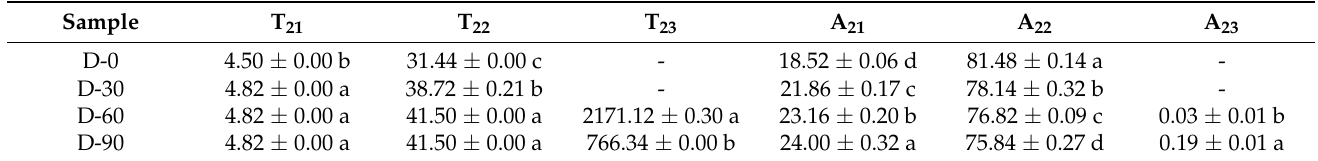
Table 2. Effect of proofing on the relaxation times, T 2 , and populations of CS–HPMC gluten-free dough.